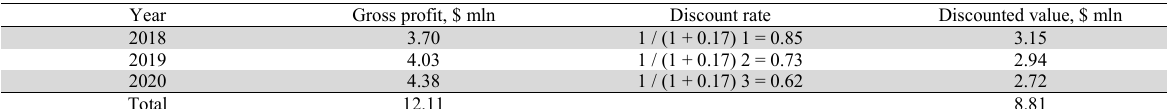
Discounted value of social